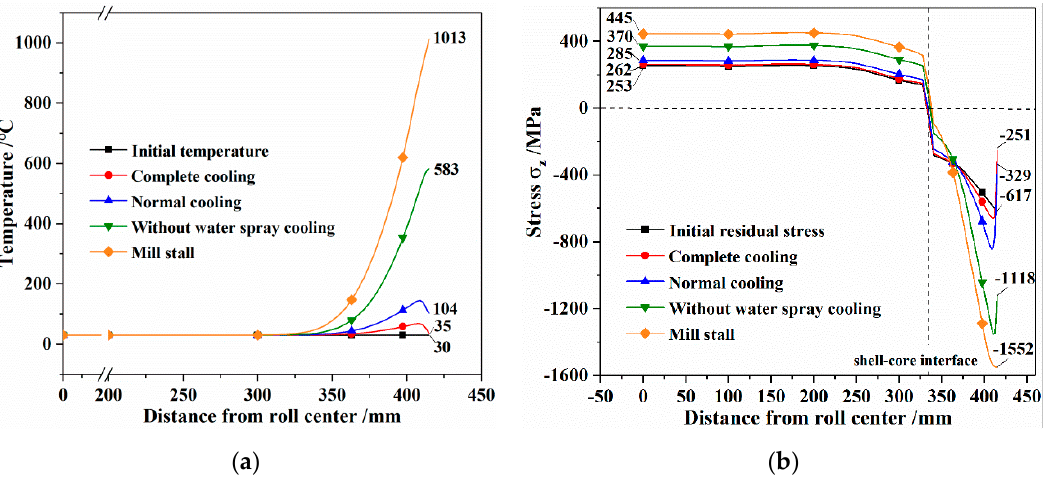
Figure 9. Distributions of temperature and thermal stress considering the initial residual stress in the radial direction of the HSS work roll after one strip rolling under different cooling conditions: ( a ) temperature distribution; ( b ) stress distribution.